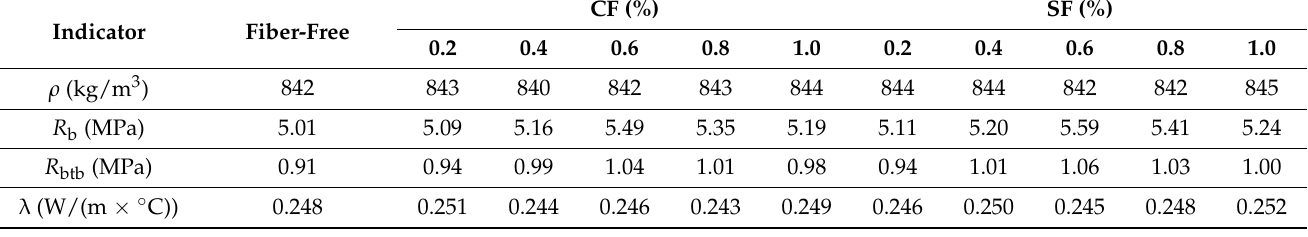
Table 14. Physical and mechanical characteristics of non-autoclaved aerated concrete modified with GGBS with different amounts of CF and SF.